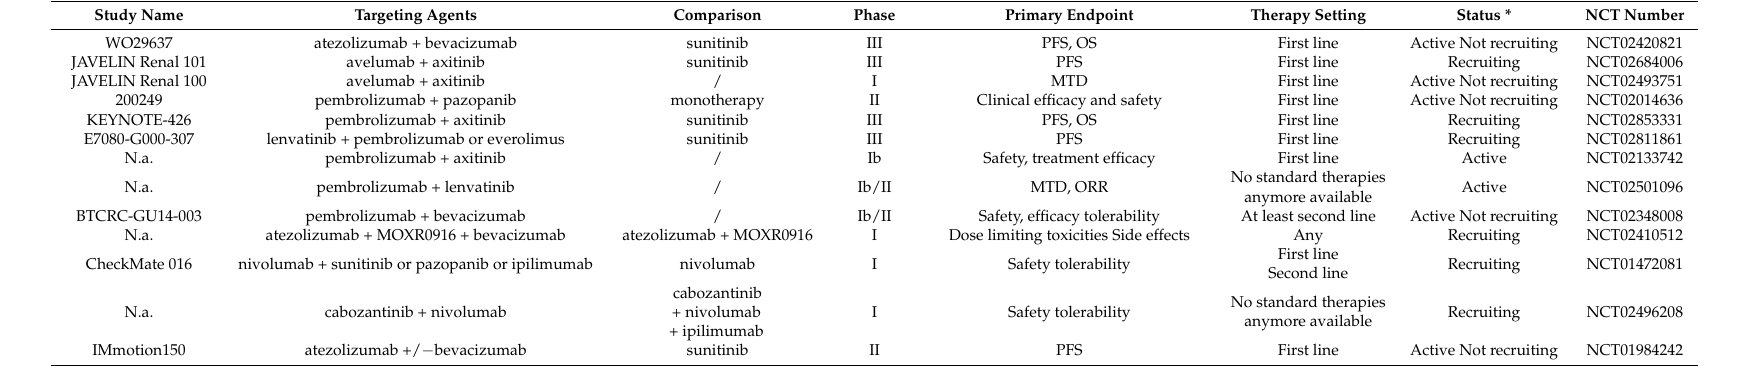
Table 3. Ongoing clinical studies combining AA and immunotherapies in